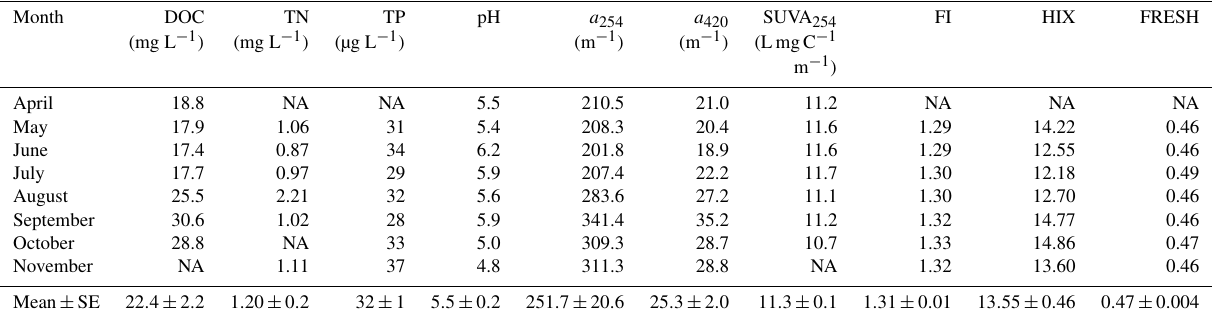
Mean ± SE 22 . 4 ± 2 . 2